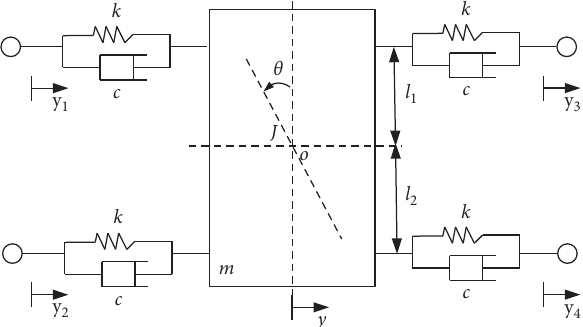
Figure 2: Dynamic model of horizontal vibration of a high-speed elevator